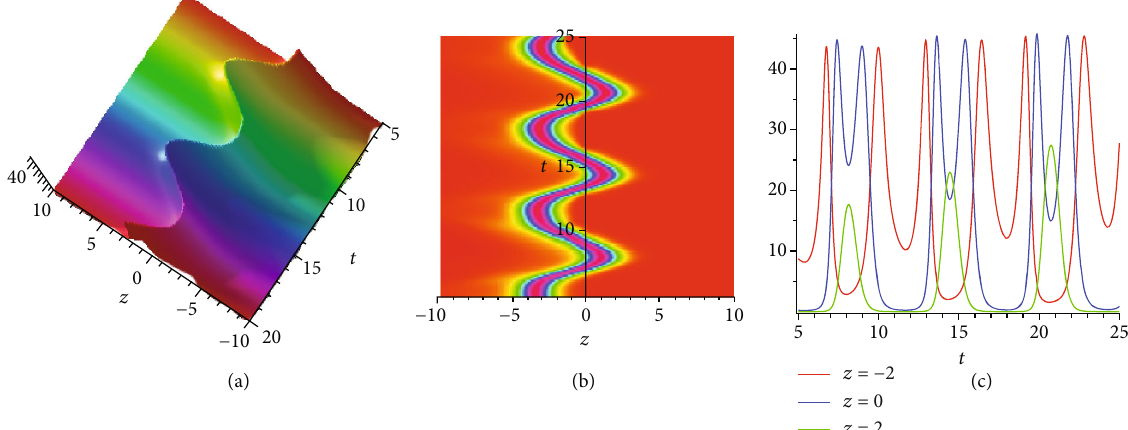
Figure 14: Plots of interaction with two lumps-soliton